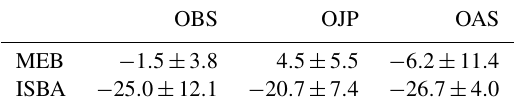
Table 5. Average and standard deviation of the BIAS between model and observations of the last day of snow expressed in num- ber of days. The OAS site has only 6 years of snow observations compared to 9 years for both the OBS and OJP.